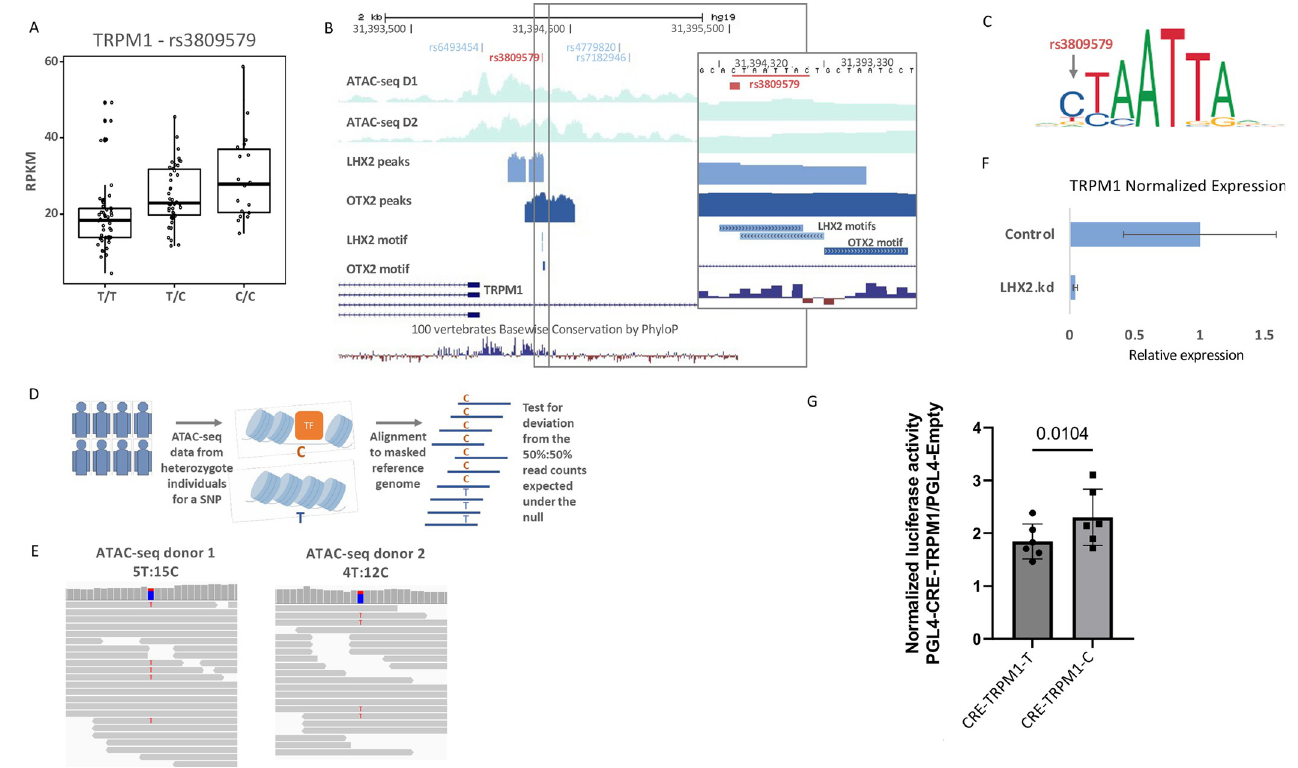
Fig 6. Identification of causal noncoding risk-SNP of AMD that modulates TRPM1 expression. (A) rs3809579 is an eQTL for TRPM1 (from http://eye-eqtl. com/; [48]). The C allele is associated with higher expression. (B) An overview of the TRPM1 genomic region including the upstream regulatory regions, the conservation in vertebrates and zoom to the rs3809579 variant (underlie in red), which is located within LHX2 and OTX2 ChIP-seq peaks in the promoter of TRPM1, as well as ATAC-seq tracks from RPE of 2 human donors (D1 and D2). (C) The T allele of rs3809579 disrupts the consensus binding motif of LHX2. The consensus LHX2 PWM is taken from the Jaspar DB [104] (accession: MA0700.1). (D) Illustration of AI analysis, conducted on samples from individuals who are heterozygotes for the examined SNP. The analysis examines significant deviations from the expected 1:1 ratio for counts of reads that originate from the 2 alleles of the examined SNP. Alleles that cause stronger transcriptional activity are expected to be associated with more open chromatin state, and thus, with higher ATAC-seq read counts. (E ) RPE ATAC-seq reads from 2 donors (d1, d2) heterozygous for rs3809579 show significantly more reads from the C allele than the alternative T allele. (F ) Expression level of TRPM1 is reduced by more than 18-fold upon LHX2 KD. (G) Luciferase assay for comparing the effect of the 2 alleles of rs3809579 on the activity of the regulatory element bound by LHX2 in the promoter of TRPM1 following LHX2 overexpression. The p - value calculated by t test, paired, two-tailed, ( N = 6, the data and analyses are detailed in S10 Table). AI, allelic imbalance; AMD, age-related macular degeneration; CRE, cis -regulatory element; eQTL, expression-quantitative trait loci; KD, knockdown; RPE, retinal pigmented epithelium; SNP, single- nucleotide